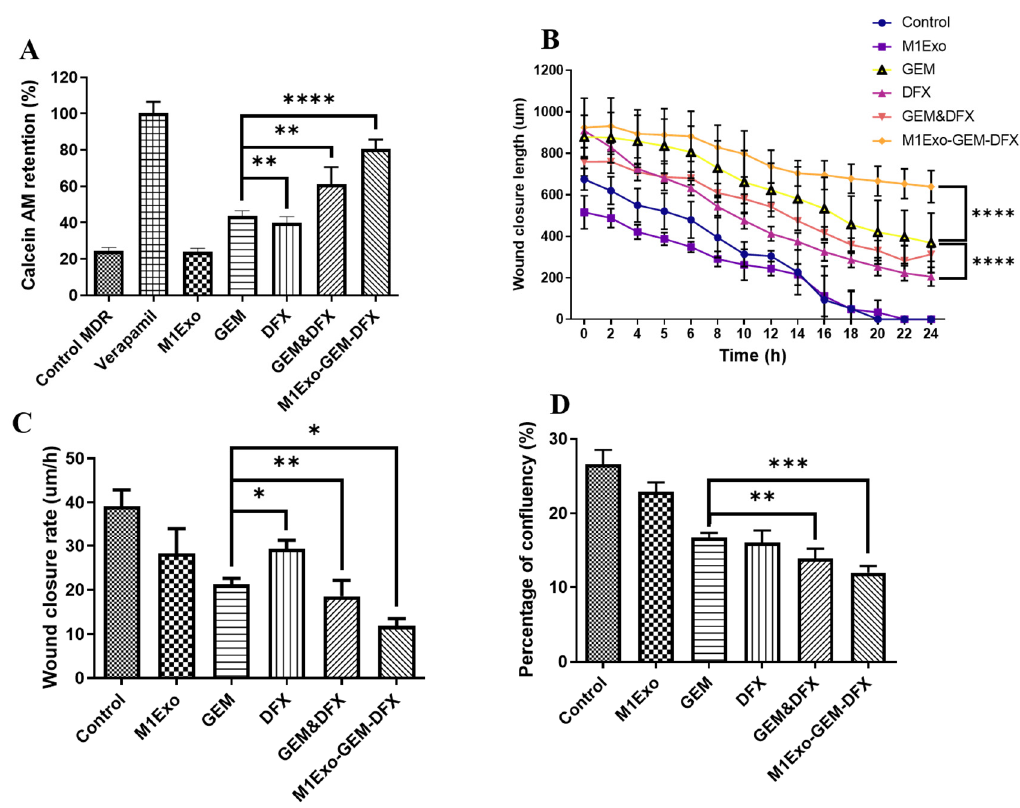
Figure 5. ( A ) Anti-MDR study of M1Exo, GEM, DFX, GEM&DFX, and M1Exo-GEM-DFX against PANC-1/GEM compared with blank and positive controls. Wound-healing study of M1Exo, GEM, DFX, GEM&DFX, and M1Exo-GEM-DFX against PANC-1/GEM: ( B ) Wound-healing assay of wound closure length. ( C ) Wound-closure rate. ( D ) Percentage of confluency measured by cell attachment assay. (* p < 0.05, ** p < 0.01, *** p < 0.001, **** p < 0.0001).